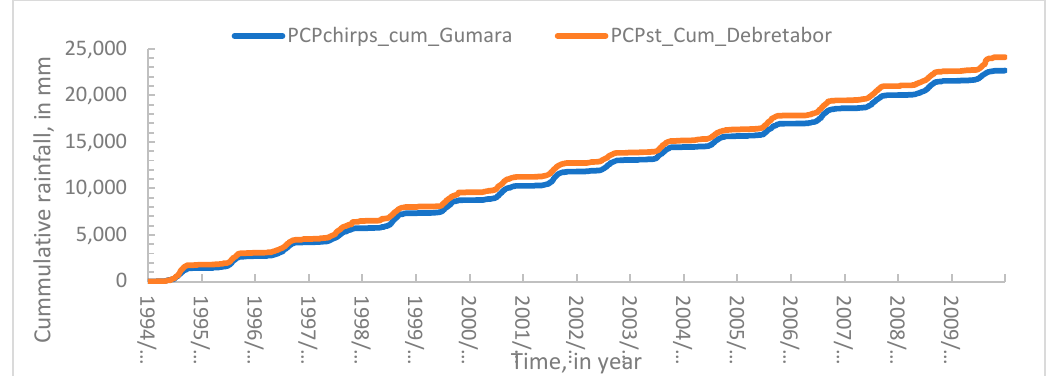
Figure 4. Cumulative precipitation measured at rain gauge stations (PCPst_Cum_Debretabor) and CHIRPS Satellite Data (PCPchirps_Cum_Gumara) versus time for Gumara river catchment (1994–2018).